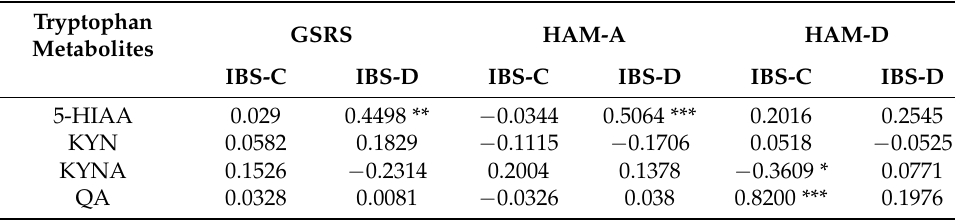
Table 3. Correlation between levels (mg/gCr) of 5-hydoxyindoleacetic acid (5-HIAA), kynurenine (KYN), kynurenic acid (KYNA) and quinolinic acid (QA) and scores of the Gastrointestinal Symptom Rating Scale (GSRS), the Hamilton Anxiety Rating Scale (HAM-A) and The Hamilton Depression Rating Scale (HAM-D) in those with IBS-C and IBS-D. The results are expressed as the Spearman’s rank correlation coefficient (rho).